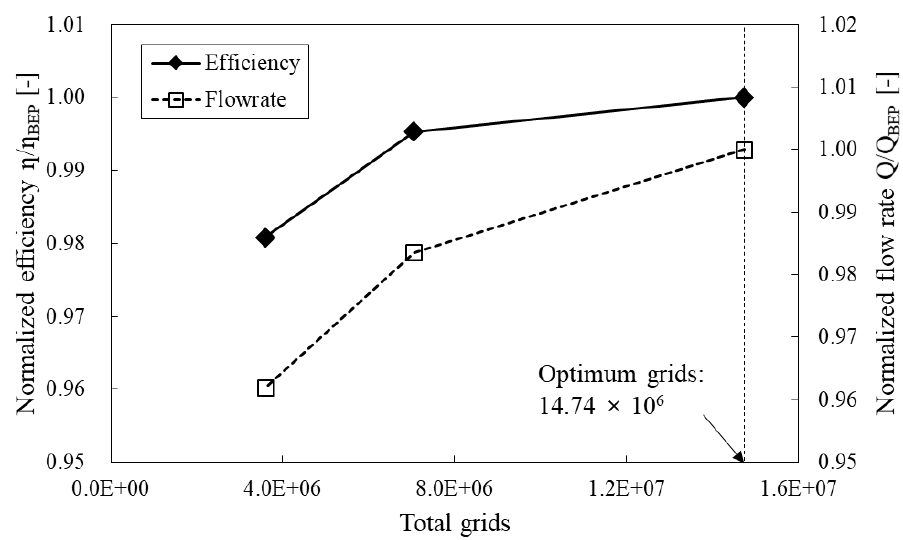
Figure 3. Comparisons of efficiency and flow rate with observed numerical grids in the Francis turbine model. Table 2. Calculation of discretization error for the Francis turbine model.